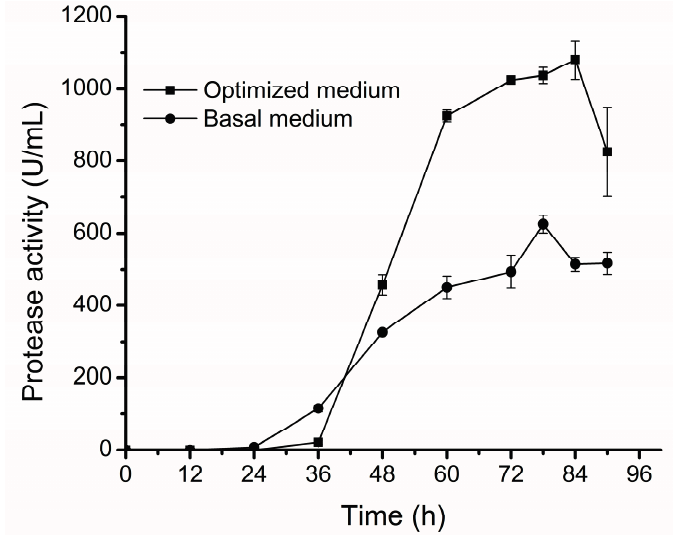
Figure 3. Comparison of the protease production of D25 in the optimized medium and in the basal medium. D25 was cultured at 15 °C and 200 rpm with 1% inoculation amount. The graph shows data from triplicate treatments (mean ±